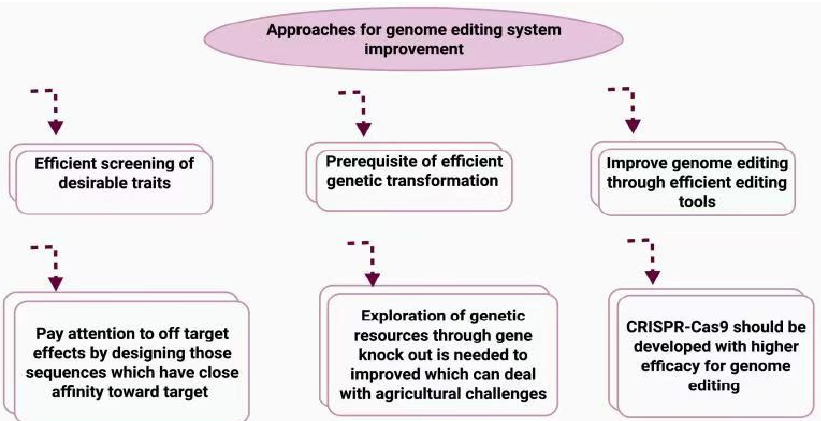
Figure 4. Novel strategies to improve genome edit using Cas9. The editing efficiency of Cas9 could be enhanced by an efficient screening of targeted characters, exploration of genetic material via the knockout of genes, and the use of an ideal gene transformation system.